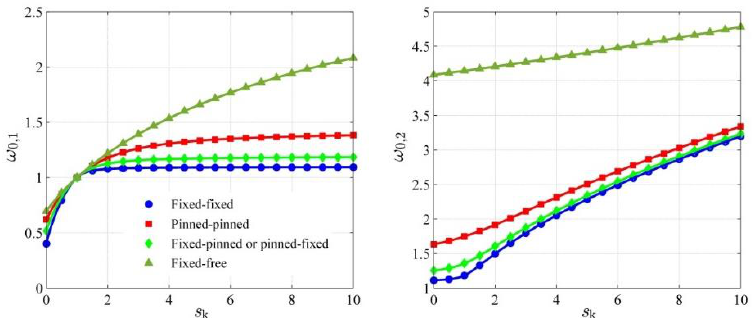
Figure 9. Frequency ratios in two sub-modes corresponding to the 1st basic mode versus beam stiffness ratio for different boundary conditions when s e = 100 and s m = 1.